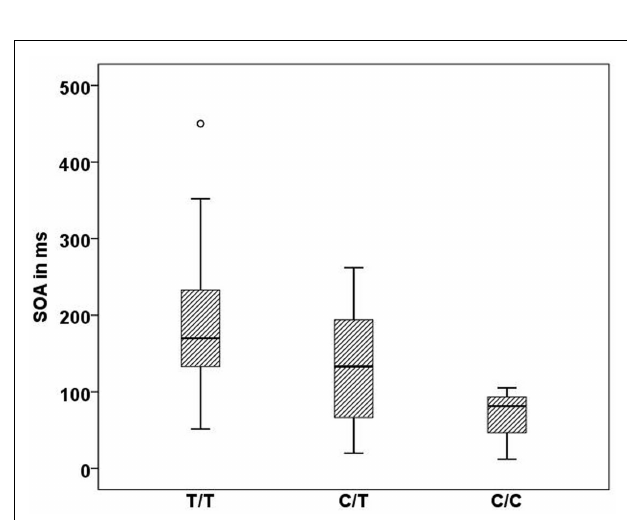
FIGURE 5 | Stimulus onset asynchrony’s of the different genotype carriers of SNP rs904952 in the Georgian patient group . SD = 95.1, p =